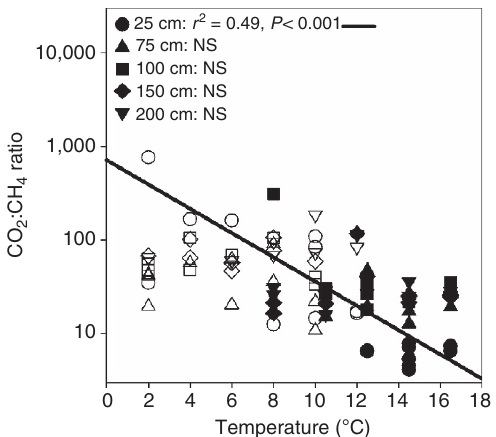
Figure 5 | CO 2 :CH 4 ratios in anaerobic incubations. Peat samples were collected from five depths and anaerobically incubated within 1 (cid:2) C of in situ temperatures after B 4 (closed symbols; September 2014) and 13 (open symbols; June 2015) months of deep peat warming. The circles indicate results from peat collected from 25cm, triangles indicate results from 75cm, squares indicate results from 100cm, diamonds indicate results from 150cm and inverted triangles represent results from 200cm. The line indicates the regression result for the 25cm incubations. NS, not significant. The log scale is worth noting.